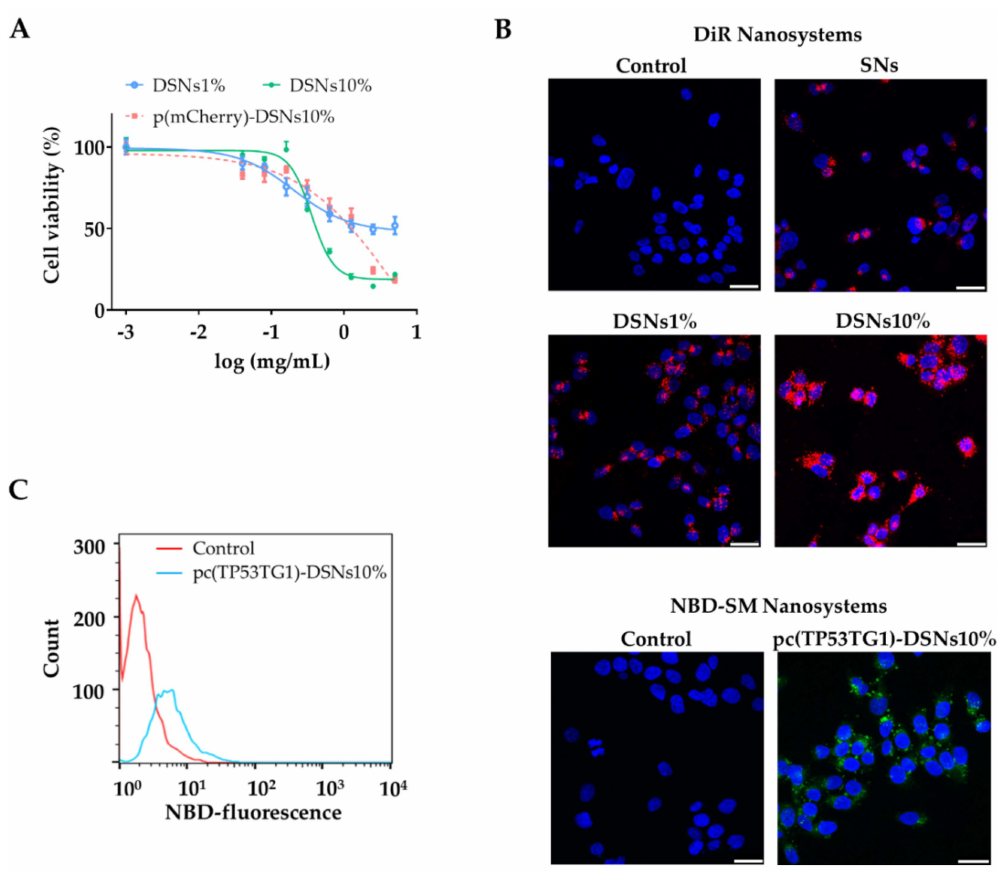
Figure 2. Nanosystems cytotoxic profile and internalization capacity on HCT-116 cells. ( A ) Blank nanosystems (SNs, DSNs1%, DSNs10%) and DSNs10% associating 10 µ g of the model plasmid encoding mCherry (pc(mCherry)-DSNs10%) were incubated for 24 h with HCT-116 cells up to 5 mg/mL and cell cytotoxicity was determined by MTT. ( B ) Confocal mi- croscopy images of internalized blank nanosystems labeled with DiR (red channel) and pc(TP53TG1)-DSNs10% (associating 10 µ g plasmid) labeled with NBD-SM (green channel). Cell nuclei were counterstained with DAPI (blue channel). Scale bars correspond to 25 µ m. ( C ) FACS analysis of HCT-116 cells positive to pc(TP53TG1)-DSNs labeled with NBD-SM (blue line) upon 4 h of incubation at 37 ◦ C. Ultra-pure water was used as control (red